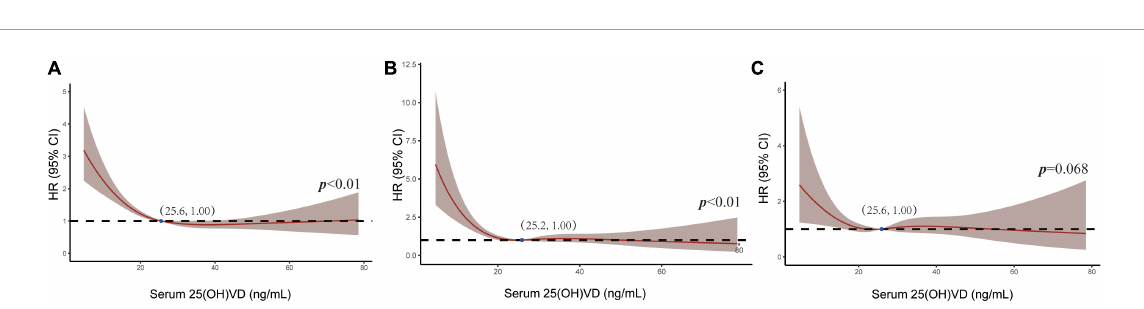
FIGURE3 The RCS between 25(OH)VD and the mortality HRs for all-cause (A) , cardiovascular (B) , and malignancies-specific mortality (C) . The brown ribbon indicates the 95%